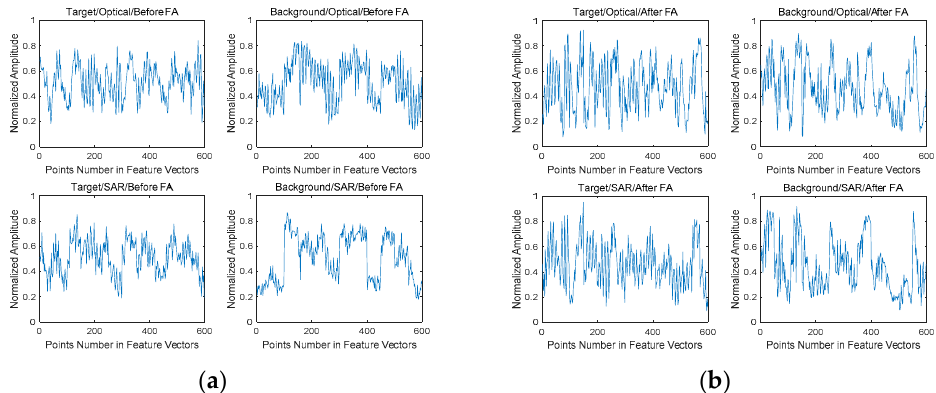
Figure 10. The slices presentation and location of correlation coe ffi cients between di ff erent couples. The four slices are: ( a ) targets in optical ( b ) background in optical ( c ) targets in SAR ( d ) background in SAR respectively. Among these, C1 is the correlation coe ffi cient of the cross-source target; C2 is of the cross-source background; C3 is of target and background in optical source; C4 is of target and background in SAR source. Corners B and A indicate before and after FA.